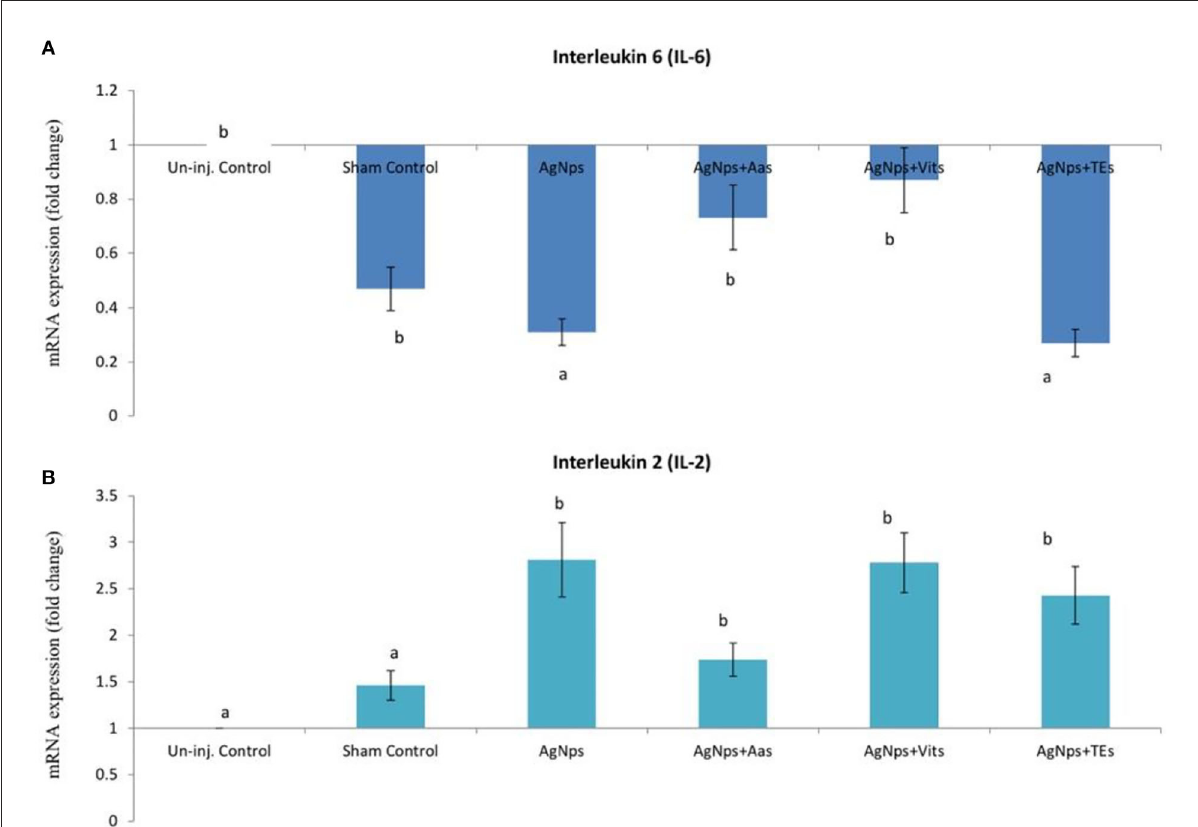
FIGURE3 Effect of in ovo administration of silver nanoparticles (AgNPs) and critical nutrients on the relative expression of IL-6 (A) and IL-2 (B) genes 8h post-virulent ND virus (vNDV) challenge. Control = un-injected, sham (sterile water), AgNPs = silver nanoparticles (50 µ g), AgNPs + AAs = silver nanoparticles (50 µ g) + amino acids (Methionine- 10mg + Arginine-25mg), AgNPs + Vits = silver nanoparticles (50 µ g) + vitamins (Vit B1-72 µ g + Vit B6-140 µ g) and AgNPs + TEs = silver nanoparticles (50 µ g) + minerals (Zn-80 µ g and Se-0.3 µ g). a,b Means bearing different alphabets in a histogram differ significantly ( P <